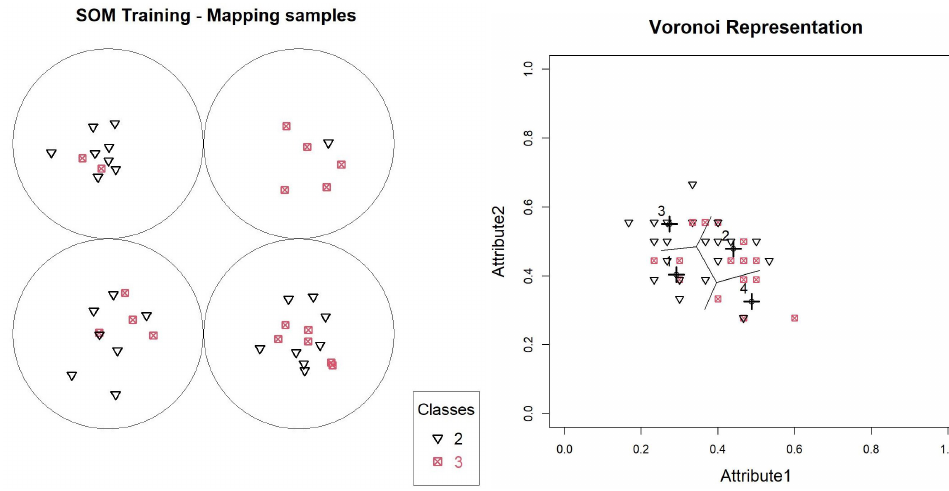
Figure 7. Object overlap per neuron and Voronoi representation—synthetic database, level 2, neu- ron 2.